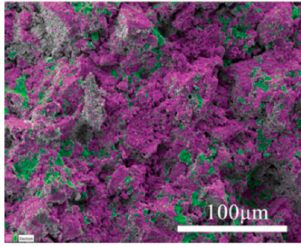
Figure 14. Energy dispersive spectroscopy (EDS) map superimposed on back scattered image of 80LAGP–20(PVDF-HFP) cold co-sintered at 120 °C and 400 MPa for 1 h before soaking in 1 M LiPF 6 ethylene carbonate-dimethyl carbonate (EC-DMC) (50:50 vol.%). Elemental Ge is shown in purple and elemental F is shown in green, adapted from reference [256] .